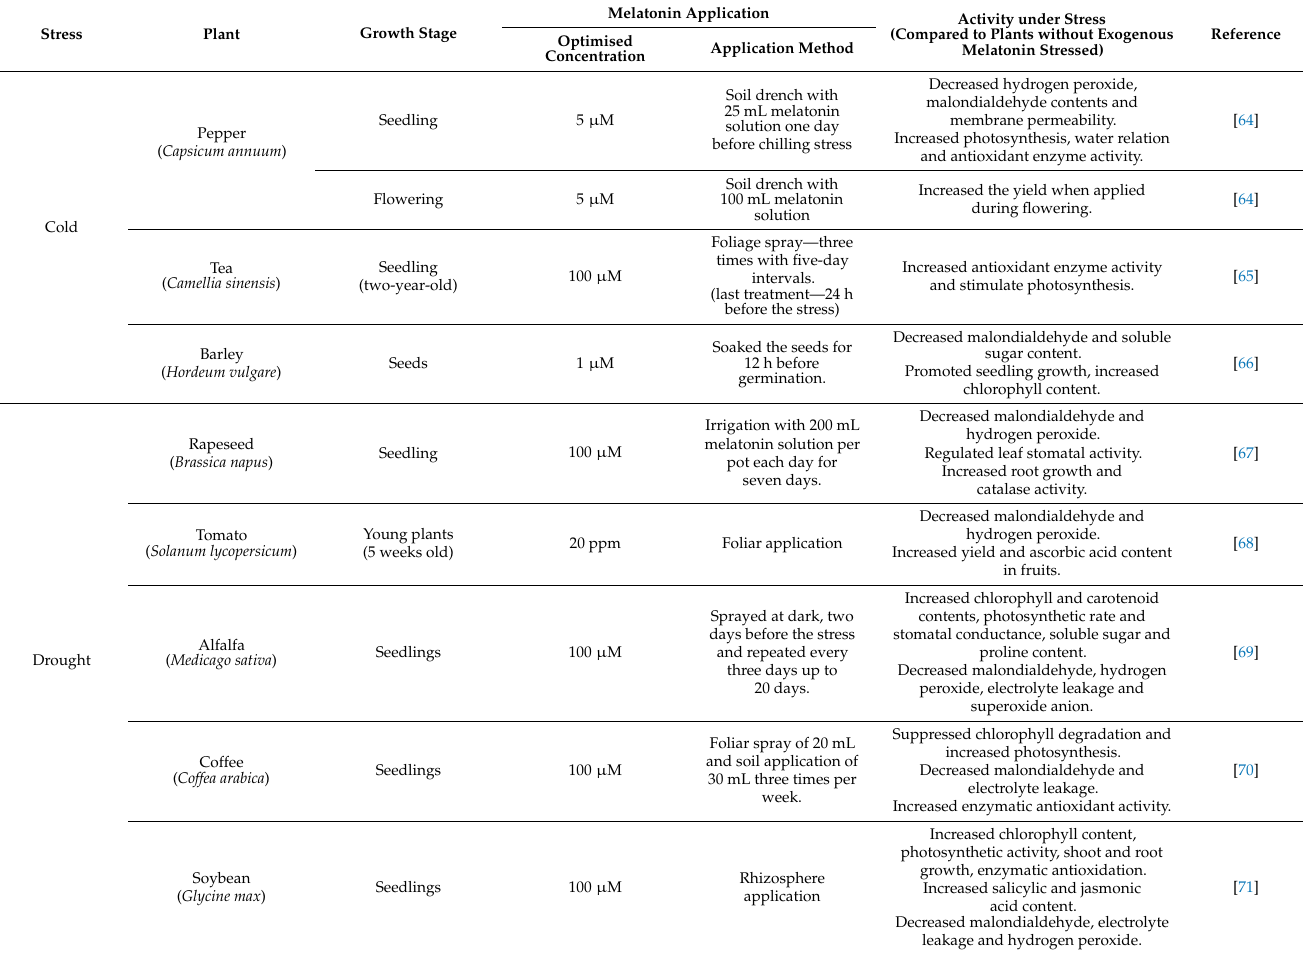
Table 2. A summary of exogenous melatonin application before abiotic stress treatment in enhancing abiotic stress